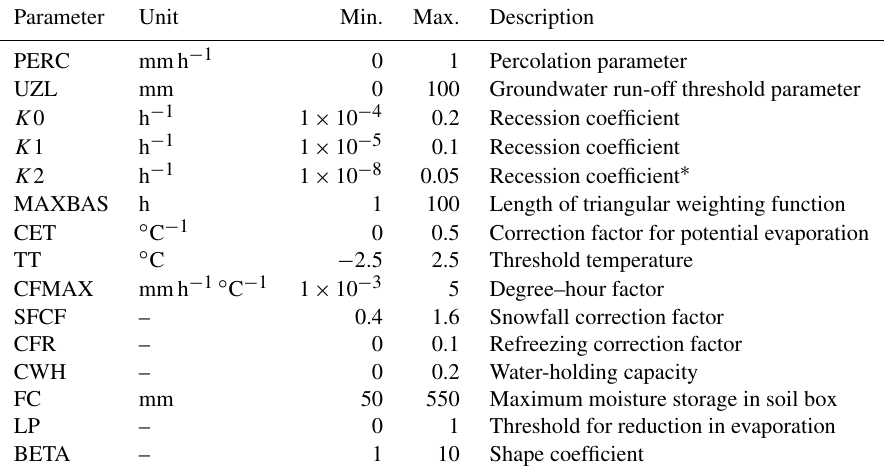
Table A1. Parameter ranges for the calibration of the HBV